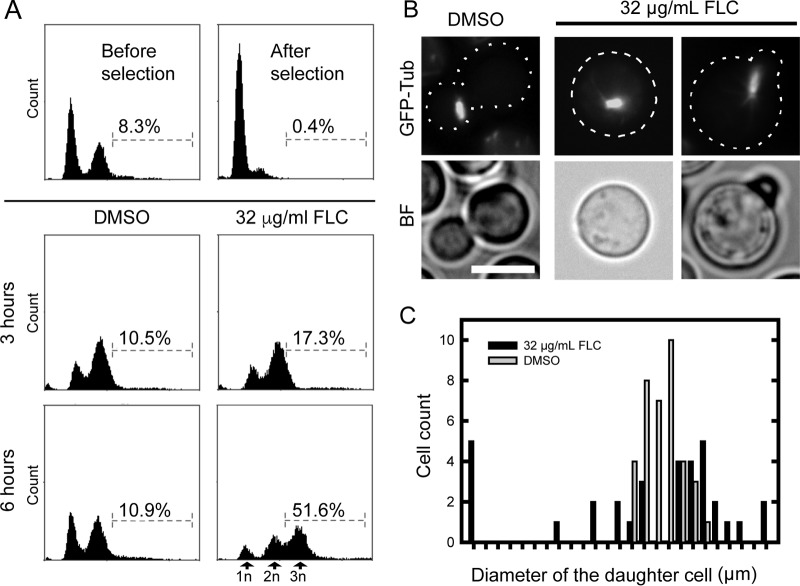
A delay or complete block in cell separation during FLC treatment may lead to an increase in DNA content in unseparated cells. (A) A population of preselected unbudded cells was incubated with 32 µg/ml FLC for 3 or 6 h (times when no multimeric cells were formed), and the DNA content was assessed using flow cytometry based on the PI staining. After 6 h of FLC treatment, ~50% of cells showed DNA content above 2N, with a predominant population (visible as a peak) that corresponded to cells with 3N DNA content. (B) FLC treatment results in an aberrant dynamics of the mitotic spindle. Localization of mitotic spindle in cells treated with 32 μg/ml FLC for 22 h was analyzed based on a strain that expressed GFP-tagged beta tubulin (GFP-Tub) (LK126). In a control sample (DMSO), the spindle was detected exclusively within daughter cells. In contrast, FLC-treated cells that had a detectable spindle either were unbudded or contained extremely small buds. BF, Brightfield. (C) The sizes of the daughter cells when the spindle was visible were relatively uniform for the control treatment (DMSO), while the FLC-treated cells exhibited a broader range of sizes of daughter cells when spindle was visible. Bar, 5 µm.